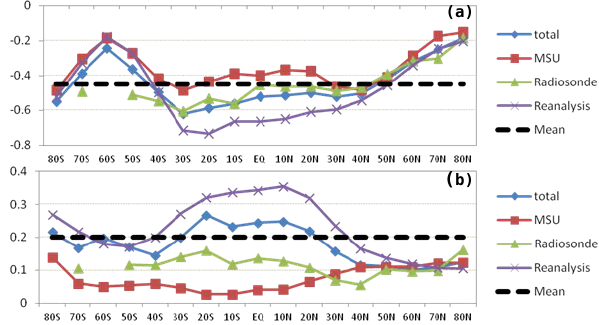
Fig. 2. Stratospheric temperature ( T CH4 ) trends (Kdecade − 1 ) (a) each group mean; (b) spread for each group . Note that the “total” is MSU + Radiosonde + reanalysis; the “mean” is the global average for all thirteen